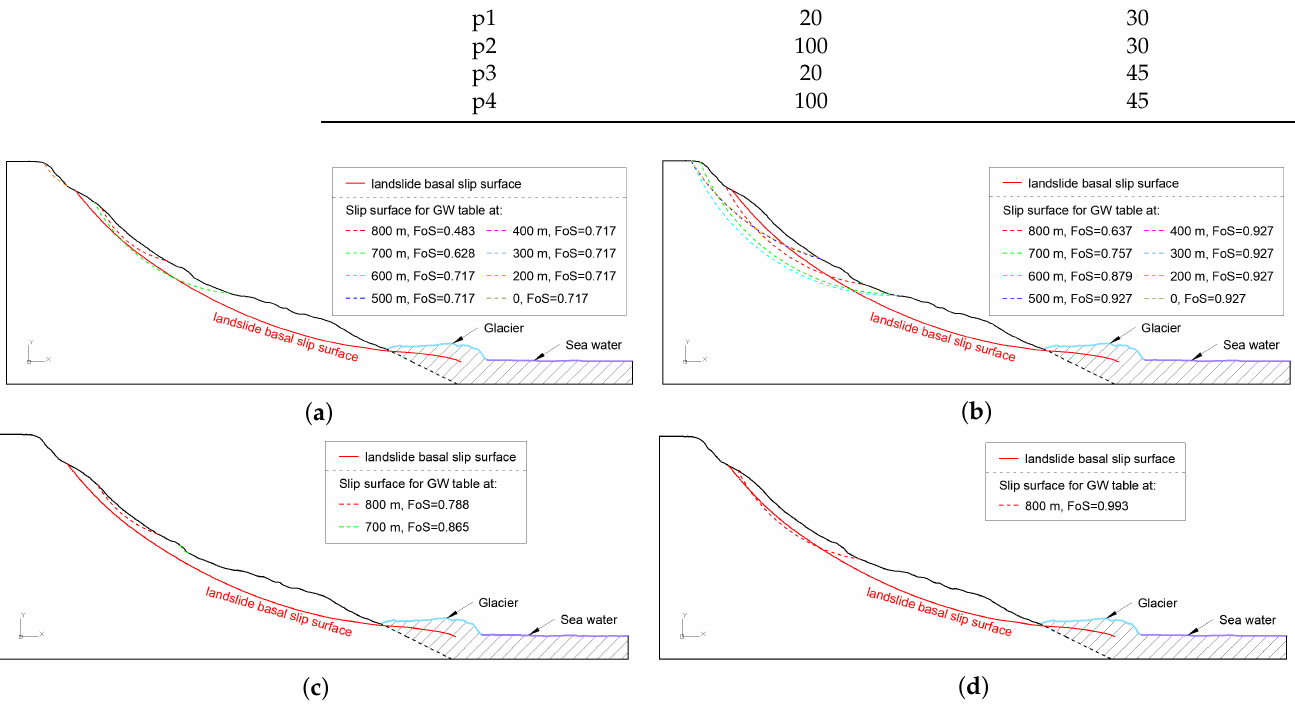
Figure 7. Sliding surfaces for groundwater table at different levels. ( a ) The results for the parameter set of p1. ( b ) The results for the parameter set of p2.( c ) The results for the parameter set of p3. ( d ) The results for the parameter set of p4. Table 6. The safety factors under different initial groundwater table conditions for the four parameter sets (p1, p2, p3 and p4) as a preliminary